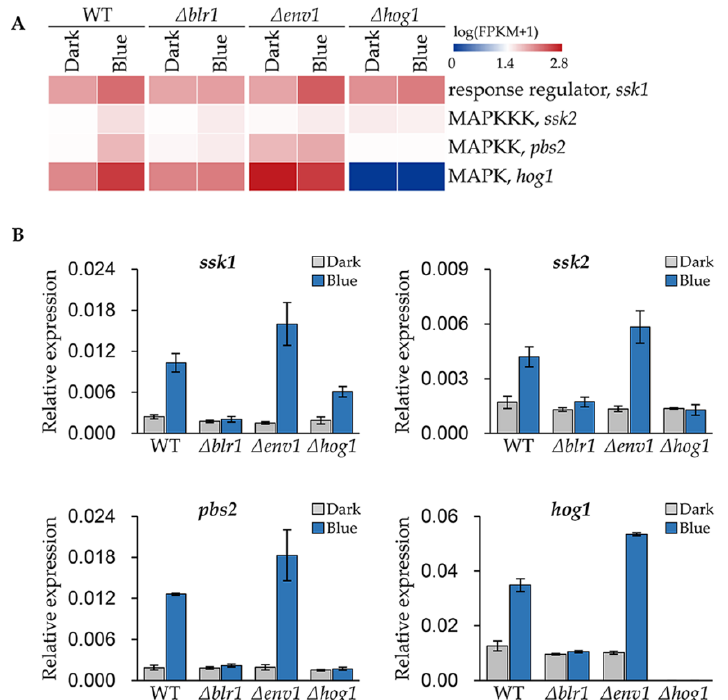
Figure 5. Analysis of transcript abundances of the HOG pathway genes in different strains. ( A ) Transcriptional abundances of the HOG pathway genes derived from the transcriptome data. ( B ) Expression levels of the HOG pathway genes in wild type, the Δ blr1 -, the Δ env1 - and the Δ hog1 -mutant strains under blue light. The expression level of each gene was normalized to the tef1 gene. Error bars indicate SD of three biological replicates.